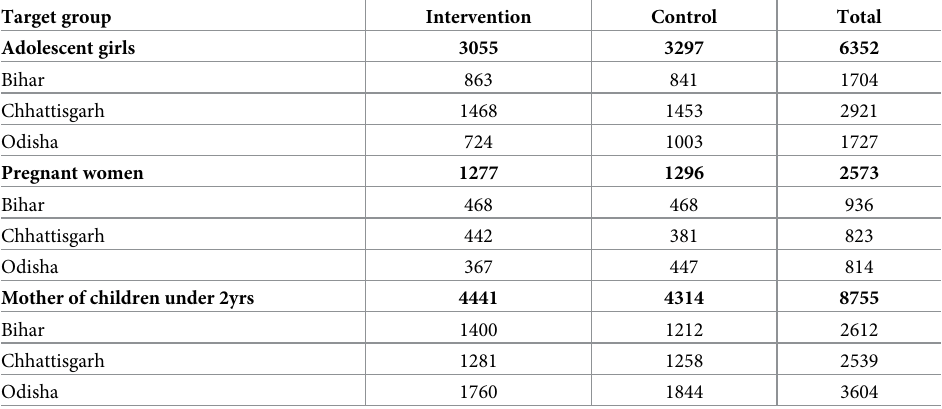
Table 3. Sampling for all target groups,